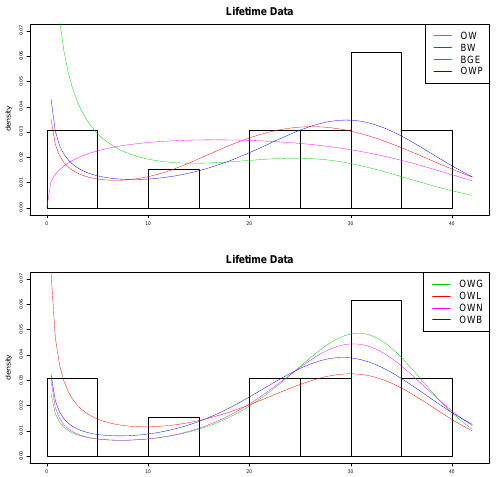
Figure 4 – Estimated pdfs of the OWPS and other competitive distributions for the second data